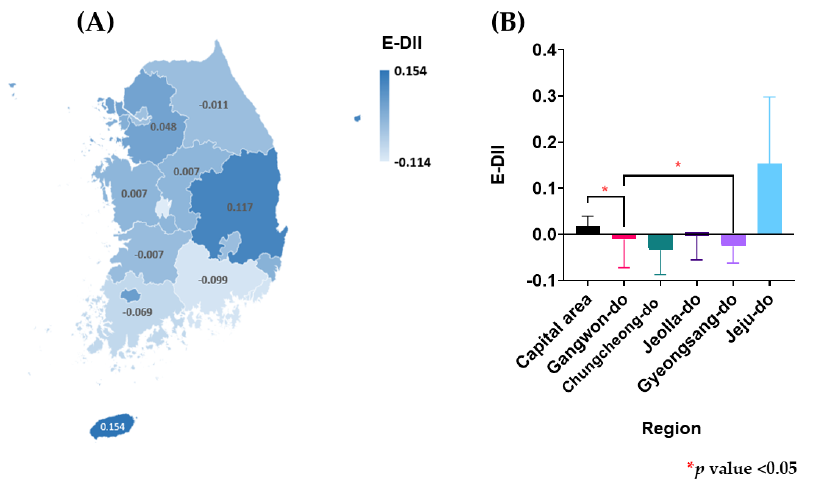
Figure 2. Mean energy-ajusted dietary inflammatory index (E-DII) score by ( A ) 16 cities and provinces and ( B ) 6 regions.